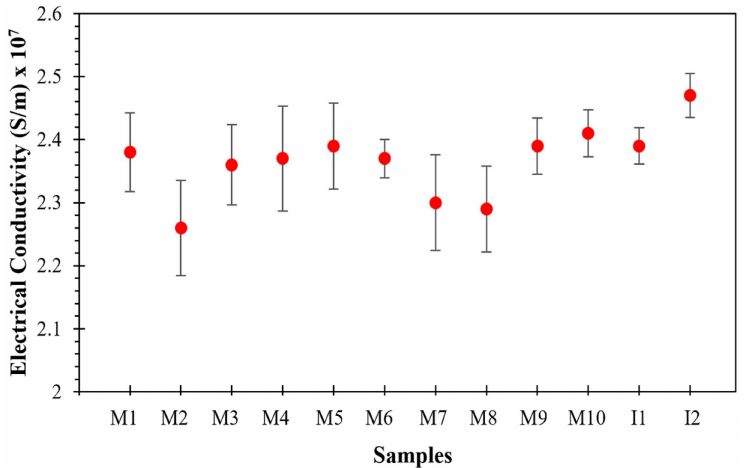
Figure 6. Measured sample electrical conductivity